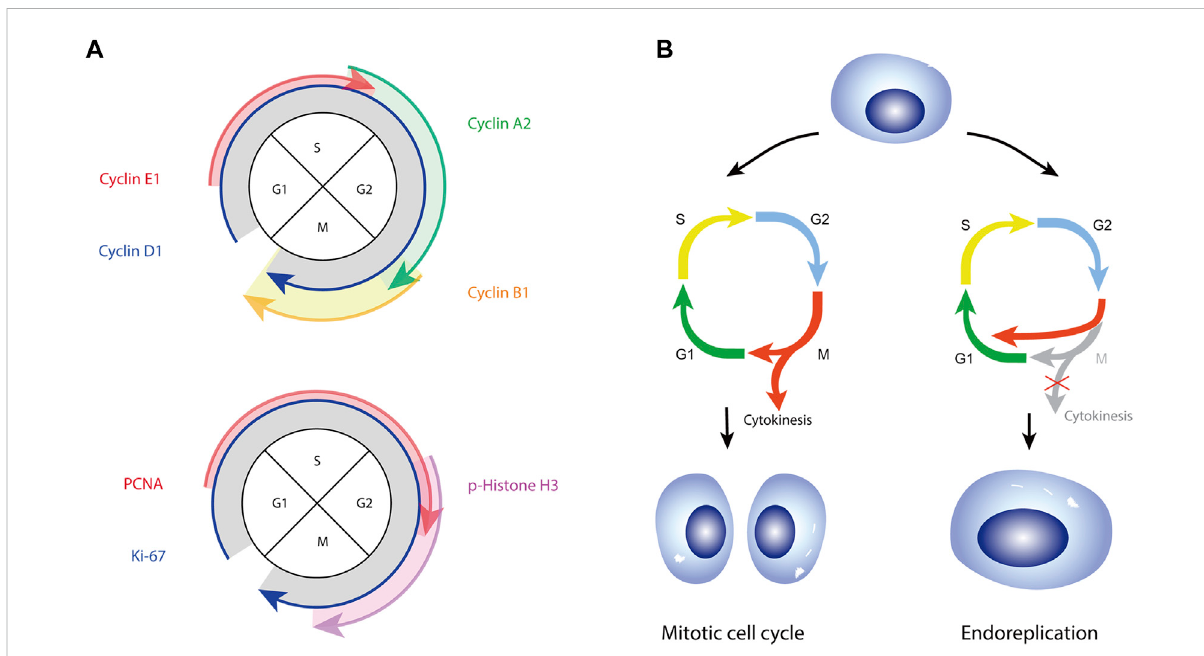
FIGURE 2 (A) Schematic of cyclin proteins (top panel) and proliferation markers (bottom panel) expressed in the four phases of a mitotic cell cycle. (B) Schematic representation of mitotic and endoreplicative cell cycles. Both cell cycle programs include phases of growth (G1 and G2) and DNA synthesis (S), however only a mitotic cell passes through M-phase and undergoes cytokinesis. A mitotic cell cycle gives rise to two diploid daughter cells. Endoreplicating cells replicate DNA but skip M-phase to return to G1, resulting in mononucleated polyploid cells (endocycle)-as demonstrated for adipocytes (Li et al., 2021) and shown in the fi gure, or pass through M-phase but fail to undergo cytokinesis, resulting in diploid binucleated cells (not